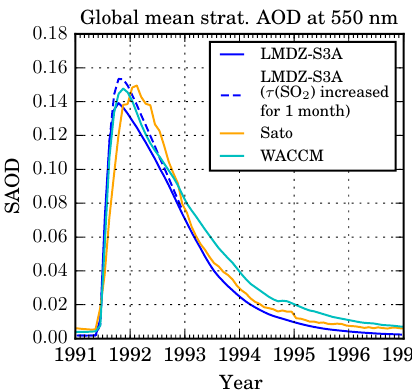
Figure 14. Same as Fig. 13, but here the dashed line shows the model result for an SO 2 lifetime doubled on the day of the eruption, decreasing linearly to climatological values within 1